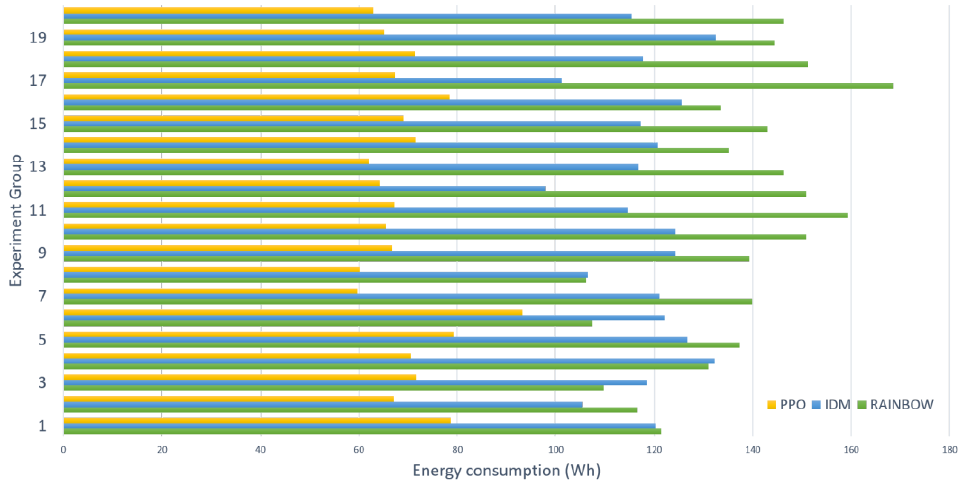
Figure 9. Energy consumption comparison for 20 groups of experiments.